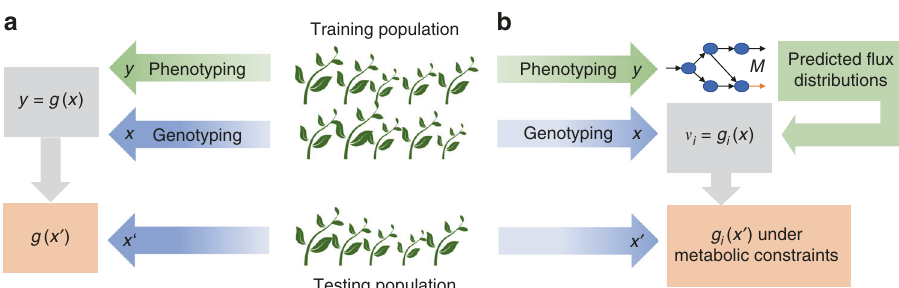
Fig. 1 Comparison of classical and network-based genomic selection. a Classical genomic selection uses a statistical model g x ð Þ , devised from genotypic data x and phenotypic data y in a training population, to predict the performance of individuals in a testing population with available genotypic data x 0 only. b Network-based genomic selection uses phenotypic data to devise accession-speci fi c metabolic models for the training population. The metabolic models are used to estimate steady-state fl uxes for each metabolic reaction over the considered genotypes and to build respective statistical models g i x ð Þ based on the genotyping data x . The statistical models are then used to identify a fl ux distribution, under metabolic constraints (e.g. steady-state), alongside the corresponding growth for a genotyped individual x 0 from the testing population.